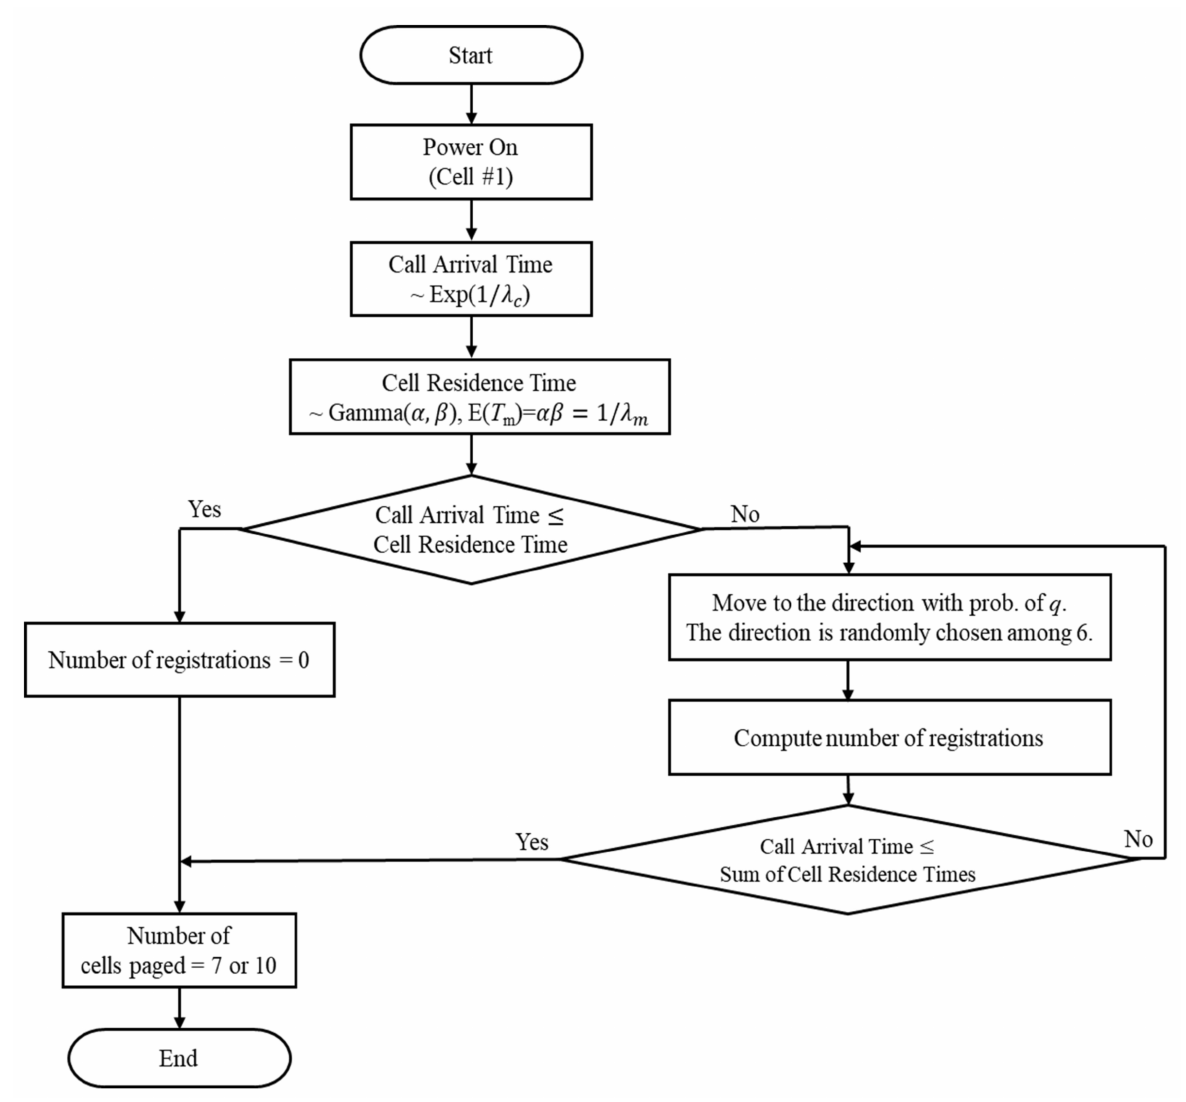
Figure 4. RAPTOR flowchart-based